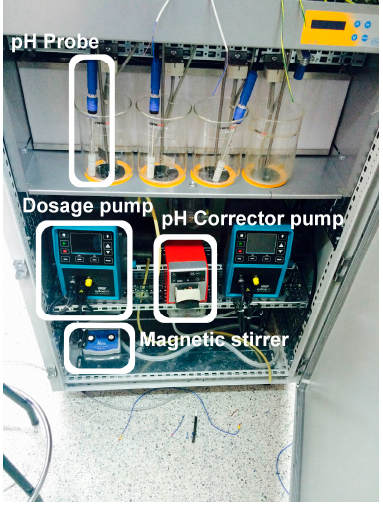
Figure 10. Front view of the prototype.